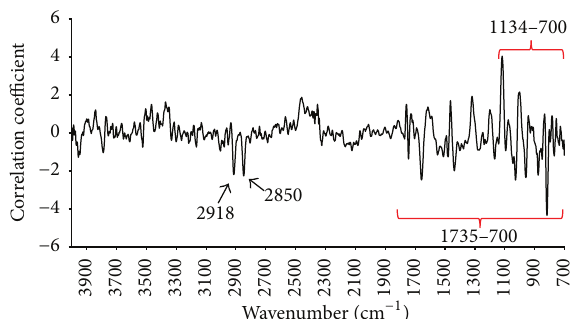
Figure 2: Average normalized ATR spectra obtained for roasted coffee (brown color), roasted coffee husks (pink color), spent coffee grounds (blue color), roasted barley (yellow color), and roasted corn (green